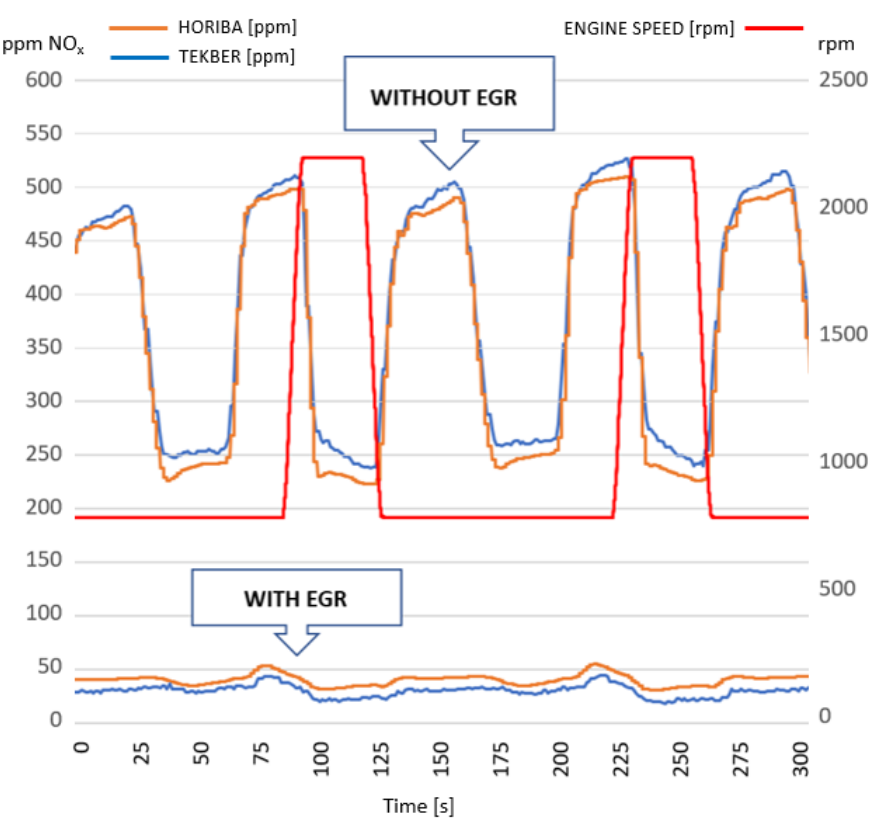
Figure 5. Comparison of Tests with and without EGR and high load